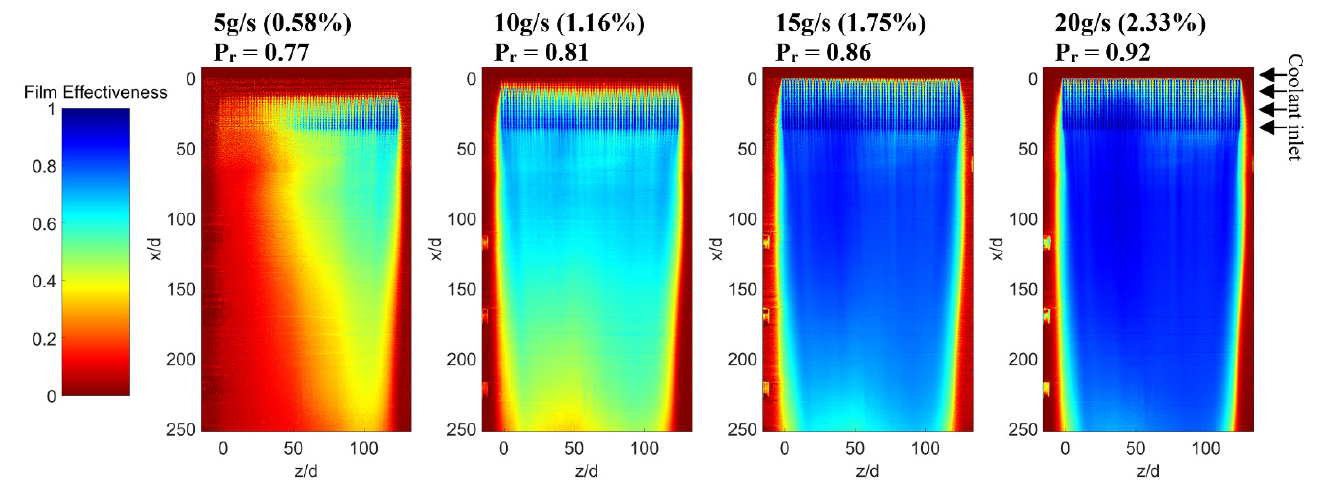
Figure 8. Film effectiveness of Panel 6 at different coolant mass flow rates (mass fraction).